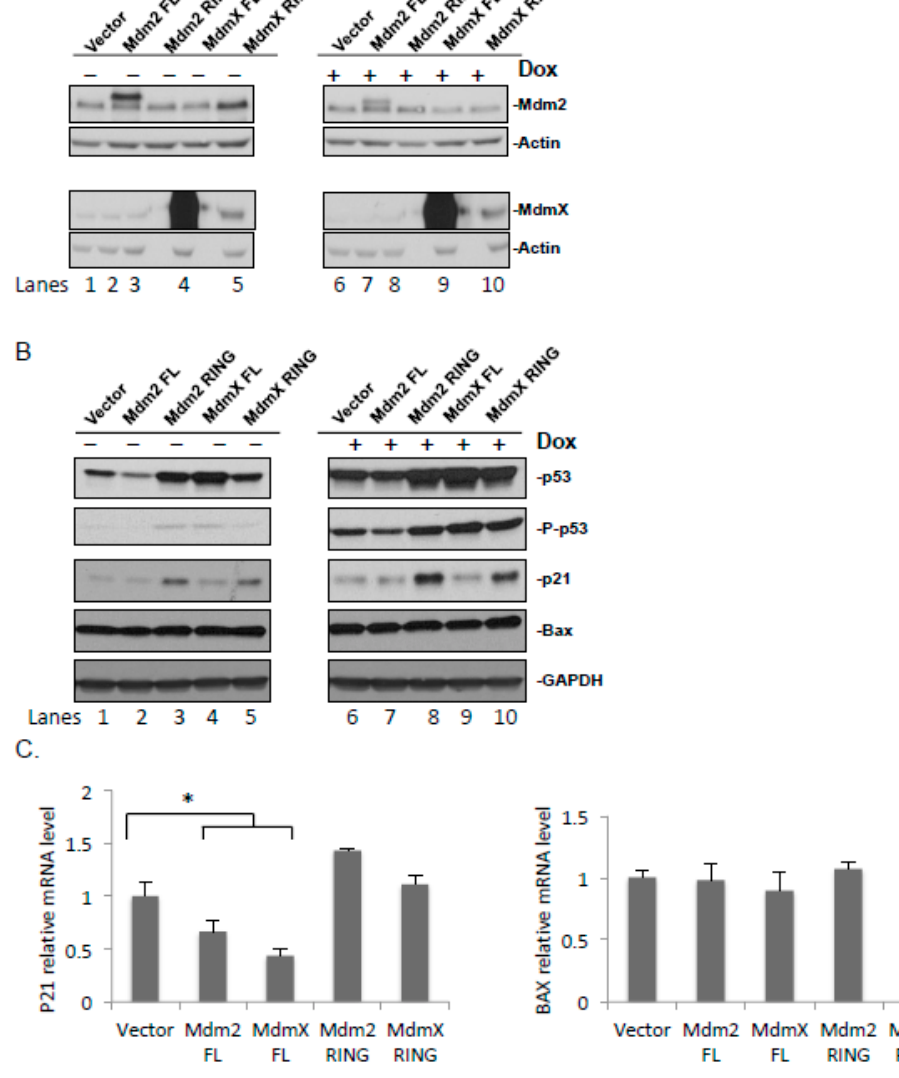
Figure 3. Effects of the ectopically expressed Mdm RING domains on p53 activation. ( A ) U2OS cells were transfected with FLAG-Mdm2, FLAG-MdmX, FLAG-Mdm2 RING, and FLAG-MdmX RING. The total cell lysate was immunoblotted for the protein levels of full-length Mdm2 and MdmX. ( B ) U2OS cells were transfected with FLAG-Mdm2, FLAG-MdmX, FLAG-Mdm2 RING, and YFP-MdmX RING. The total cell lysate was immunoblotted for the protein levels of p53, phosphorylated p53 at Ser15, p21, and Bax. ( C ) U2OS cells were transfected with FLAG-Mdm2, FLAG-MdmX, FLAG-Mdm2 RING, and FLAG-MdmX RING. Relative mRNA expression levels of p21 ( CDKN1A ) and Bax ( BAX ) were analyzed. Results are expressed as Mean ± SEM of three biological replicates. Expression levels of p21 and Bax in the vector control are taken as 1. The results were analyzed using statistical one-way ANOVA test. * p ≤ 0.05.